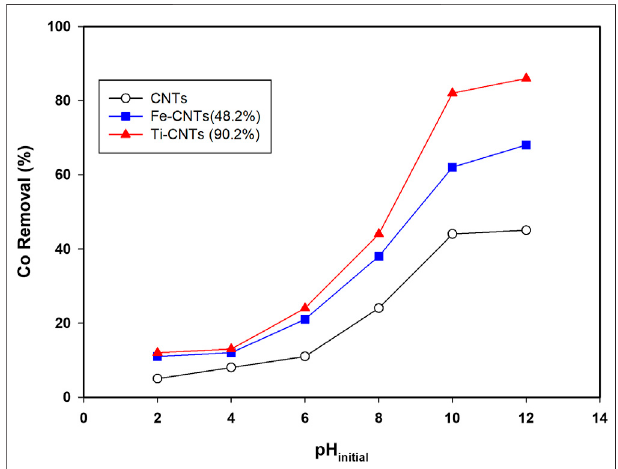
FIGURE 3 | In fl uence of solution pH on Co removal (Conditions: mass 5.0 mg, Co level 20 mg/L, temp (cid:1) 30 ° C, and shaking time 24